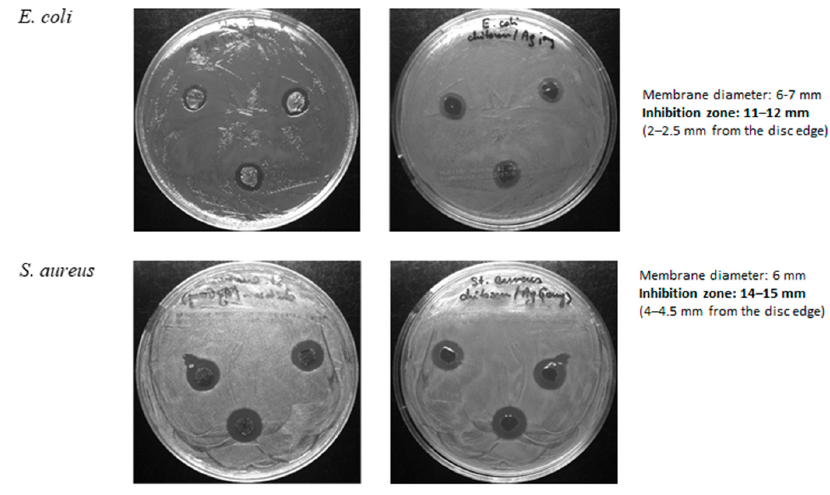
Figure 13. Images of the growth of Escherichia coli and Staphylococcus aureus bacteria strains on agar plates with BP/AgP.